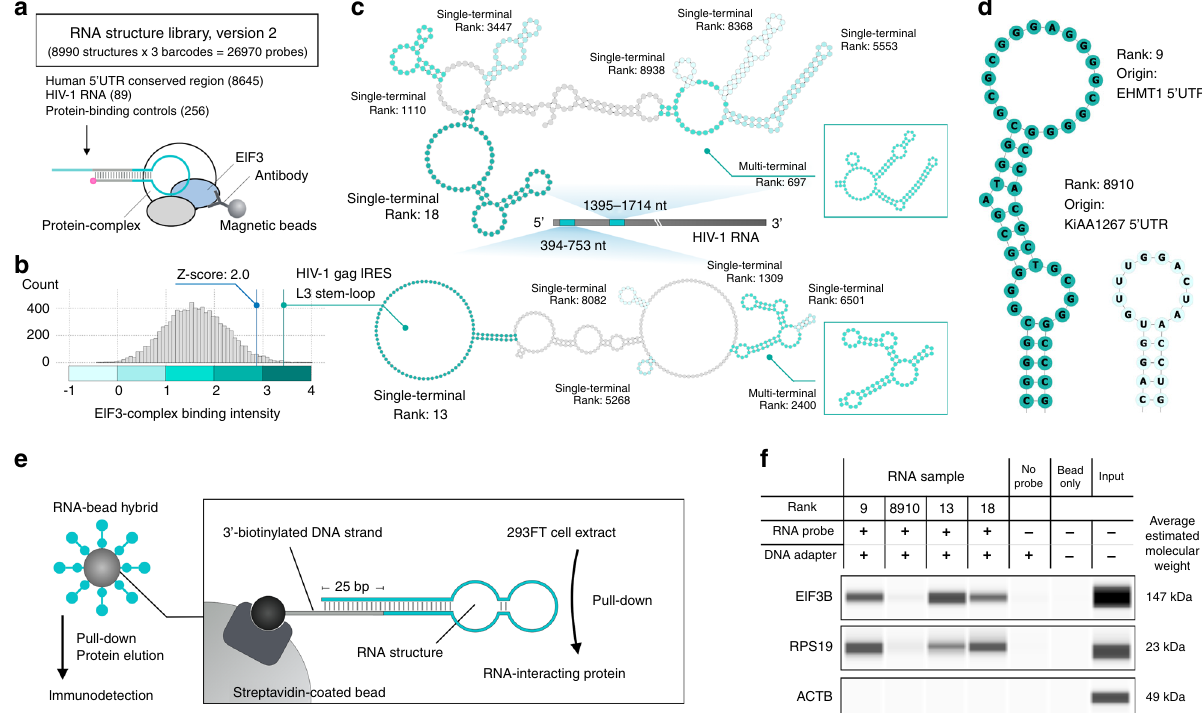
Fig. 6 Systematic identi fi cation of protein-binding RNA elements from large-scale RNA structural architecture. a Schematic of RNA immunoprecipitation with an anti-EIF3B antibody and RNA structure library, version 2. The numbers of target RNA structures are described in parentheses. The 293FT cell-derived EIF3 complexes were immobilized on the antibody-conjugated beads. b RNP interactions of the EIF3 complex. The data were calculated from two independent experiments. A histogram of binding intensities with the positive control (green line) and Z -score = 2.0 (blue line) is shown. The terminal motif derived from HIV-1 gag IRES was a positive control. The colored bar indicates the binding intensities for the functional annotation. c A structure-wide functional annotation of the HIV-1 RNA secondary structures. The color of each structure was determined by the binding intensity; the library does not include RNA structures that contain gray-colored RNA residues. d Representative EIF3-complex binding structures from human 5 ′ UTRs. e Schematic of the pull-down assay with an RNA – DNA – biotin hybrid. The target RNA structure was immobilized on a streptavidin-coated magnetic bead using a biotinylated tethering DNA strand. Enriched proteins in the bound fraction were collected by magnetic separation and analyzed by capillary-based immunodetection. f Gel images of the microcapillary-based immunodetection with anti-EIF3B, anti-RPS19, and anti-ACTB antibodies. The image shows representative data from two independent experiments. Average molecular weights were calculated from size markers and ladders. Source data are provided as a Source Data fi